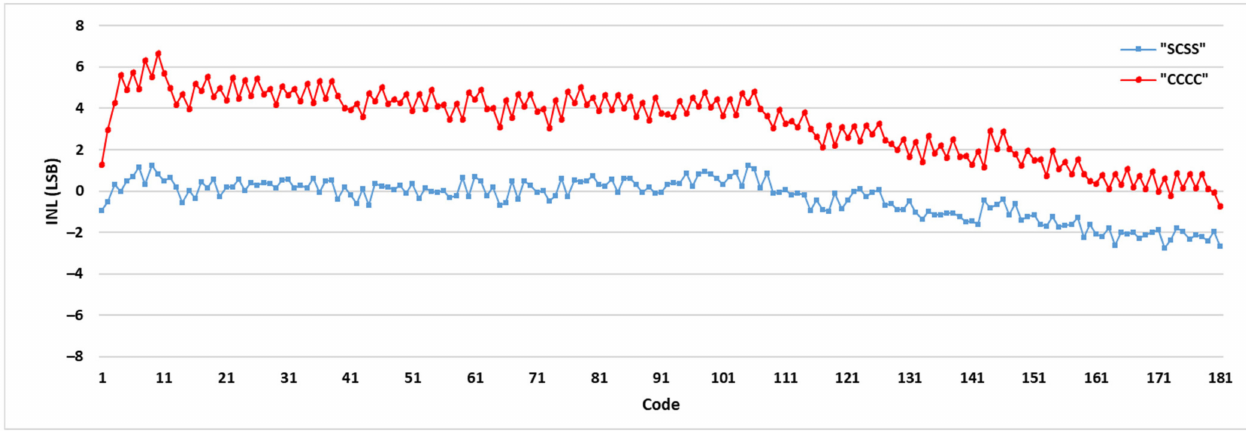
Figure 7. INL results of “SCSS” and “CCCC” sampling